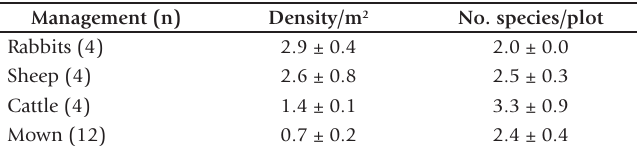
Table 2. Density and species richness of Orthoptera on Essex sea walls (UK) with differing management (Gardiner unpublished data,